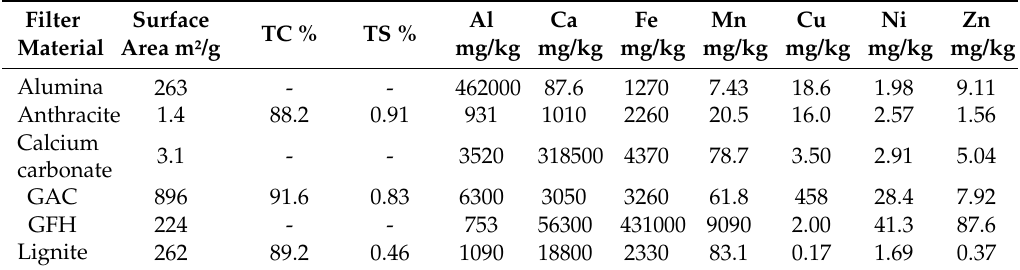
Table 1. Physical characteristics of sorbents (based on dry